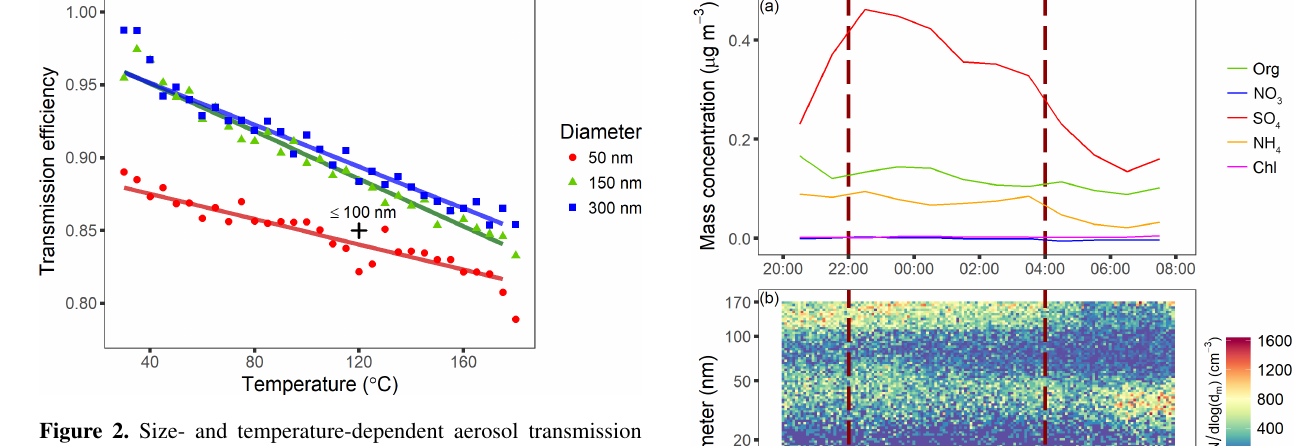
Figure 2. Size- and temperature-dependent aerosol transmission rates of the TD sampling line compared to the unheated line for AS aerosol. The value used in this study for aerosol ≤ 100nm has been marked for comparison.